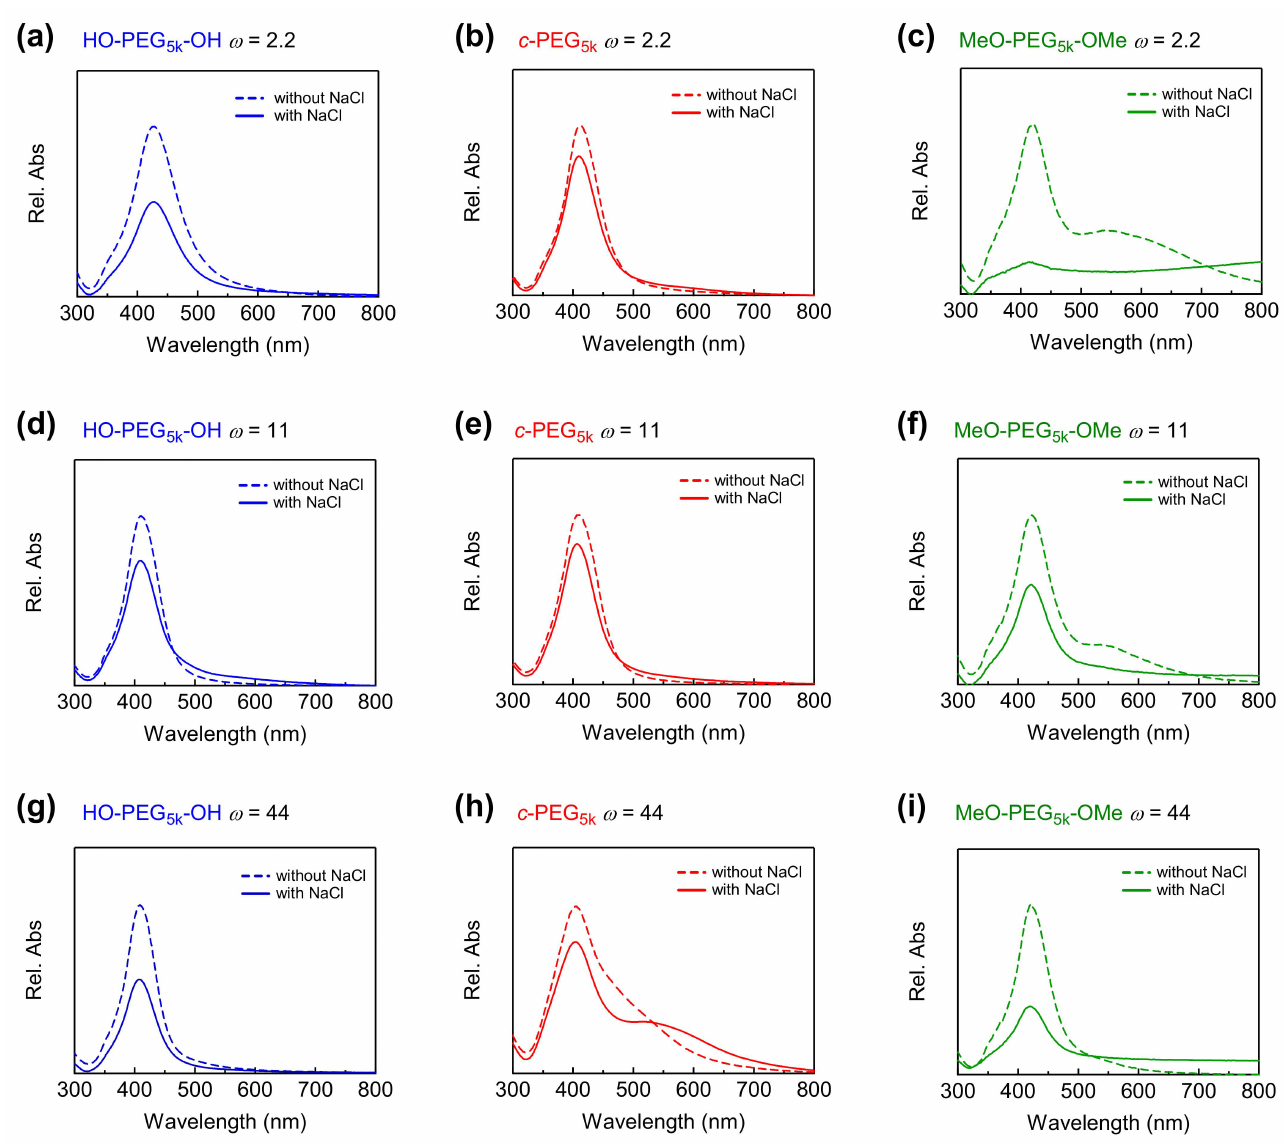
Figure 2. Relative UV–Vis absorption spectra of AgNPs without NaCl (dashed line) and with 37.5 mM of NaCl (solid line) in the presence of ( a ) HO–PEG 5k –OH, ( b ) c -PEG 5k , ( c ) MeO–PEG 5k – OMe at ω = 2.2, ( d ) HO–PEG 5k –OH, ( e ) c -PEG 5k , ( f ) MeO–PEG 5k –OMe at ω = 11, ( g ) HO–PEG 5k –OH, ( h ) c -PEG 5k , and ( i ) MeO–PEG 5k –OMe at ω =